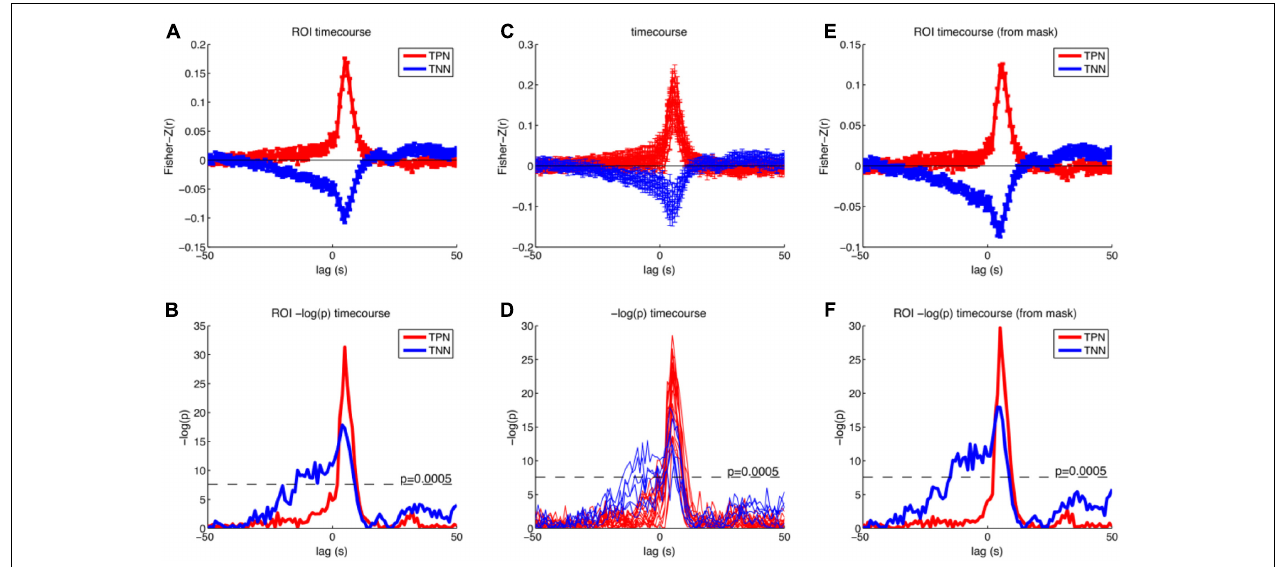
FIGURE 6 | Results of the cross correlation analysis between the (time shifted) fMRI signal and the response times for selected regions. Upper row shows Fisher-Z normalized and averaged correlation coefficients and standard error of the mean for different time lags. Lower row shows –log(p) of the t -test on the Fisher-Z normalized correlation coefficients for different time lags. (A,B) Timecourses averaged across all reported peak coordinates from the parametric GLM separately for the positive (red) and negative (blue) modulations ( Tables 1 , 2 , except cerebellum). (C,D) Timecourses separate for all reported peak coordinates from the parametric GLM. Red: positive modulation; Blue: negative modulation. (E,F) Timecourses averaged across all voxels that were positively (red) or negatively (blue) modulated with the response time from the parametric GLM with a threshold of p < 0.05 (FWE corrected at the voxel level). Correlations rise earlier for the negative correlations and have also higher p -values. Task positive network (TPN), task negative network